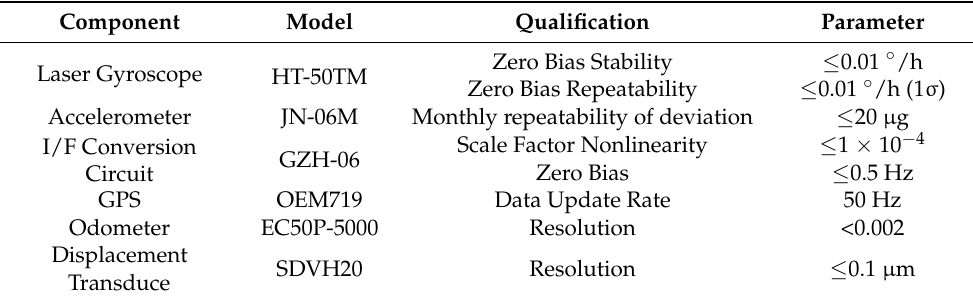
Table 1. The main components and technical indicators of the inertial track detector.